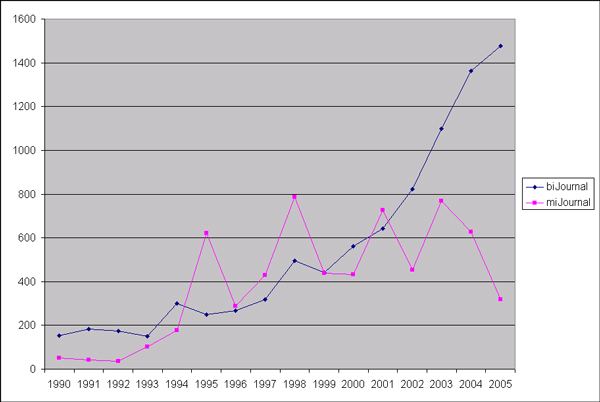
Sample figure title. Distribution of the publications from the BI journal corpus and from the MI journal corpus over time. The number of publications continuously increased BI domain a continuous increase in publications in the used journals took place. In the MI field the number of publications fluctuated over time, which might be the result of conferences that did not take place every year. Relative low publication figures in 2005 are partly due to the fact that not all publications of 2005 have yet been incorporated into the Medline distribution. Nevertheless, the publication number in 2005 in the BI field showed already an increase in published articles, which could be the result of open access publishing.